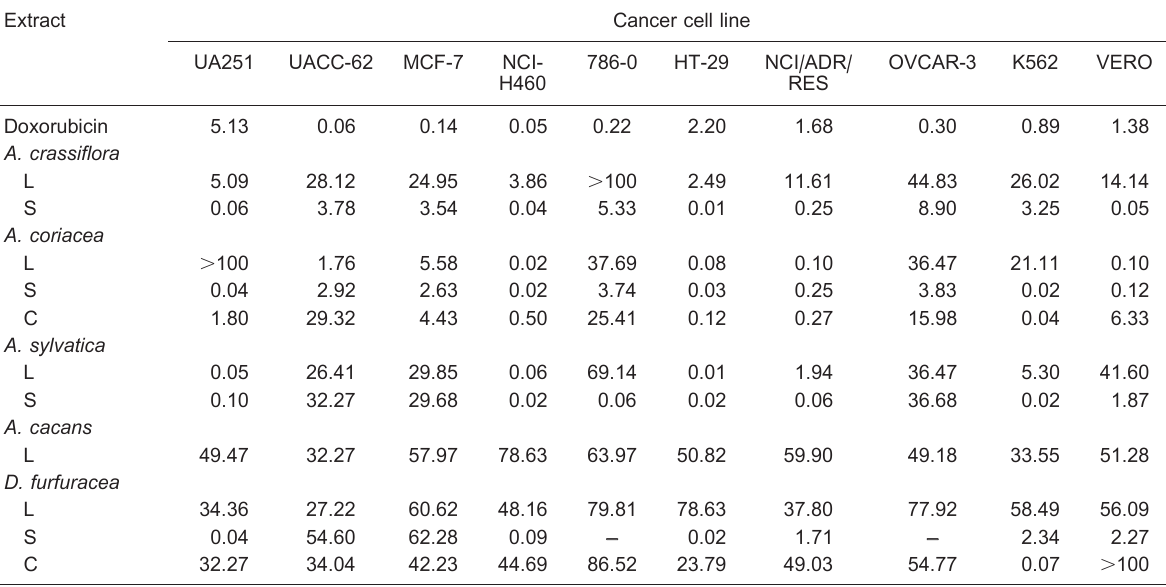
Table 2. In vitro antitumor activity (GI 50 in m g/mL) of the methanolic extracts from the Annonaceae plants against the tumor cell lines. Extract Cancer cell